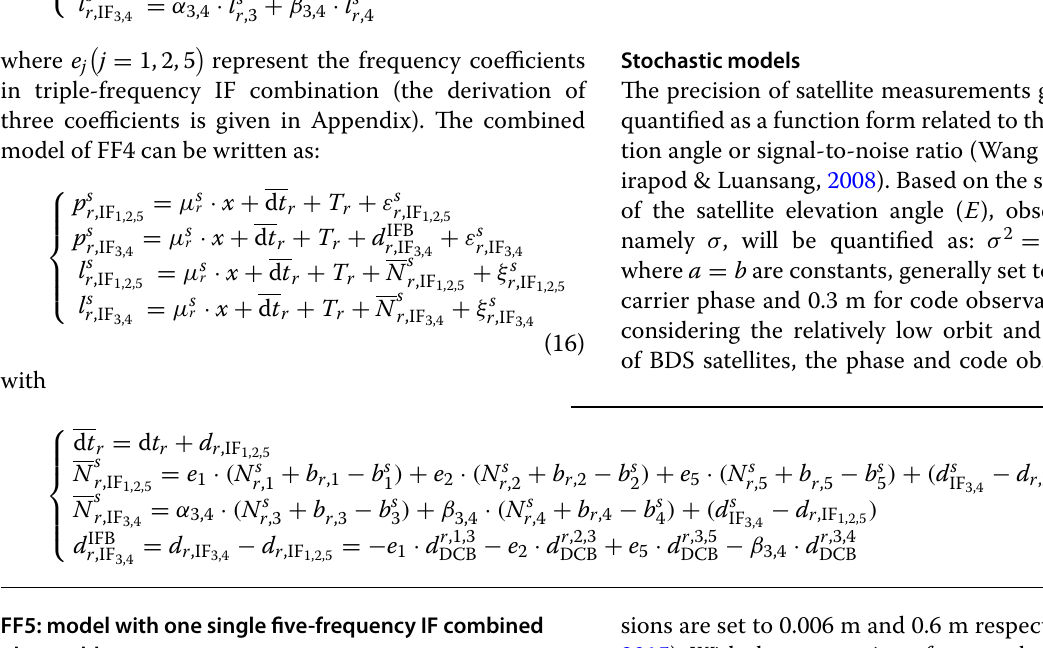
FF5: model with one single five‑frequency IF combined